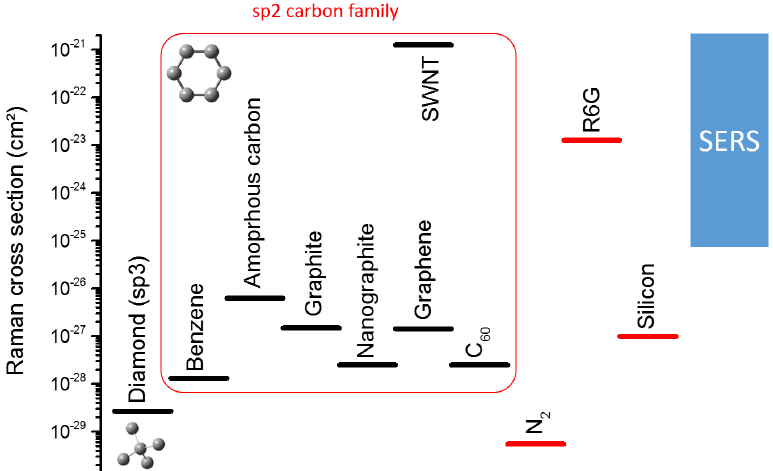
Figure 10. Raman cross section for carbonaceous materials compared to reference materials. Sources: Diamond [154], graphene [49], nanographite [65], benzene [155], silicon [156], SERS [157]. Note that